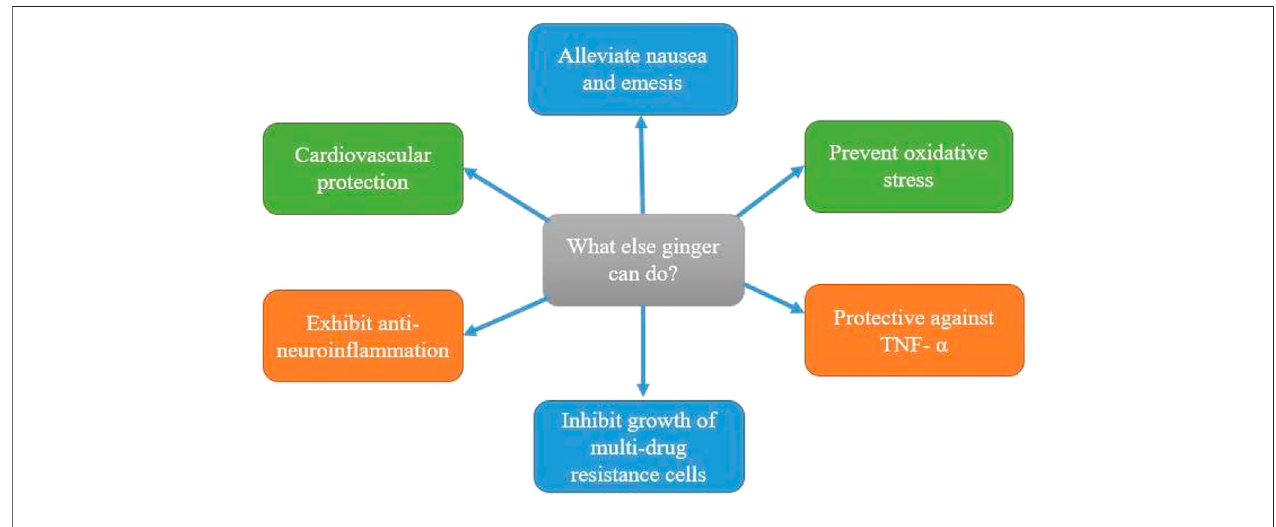
FIGURE 5 | Health bene fi ts and anticancer properties of ginger.